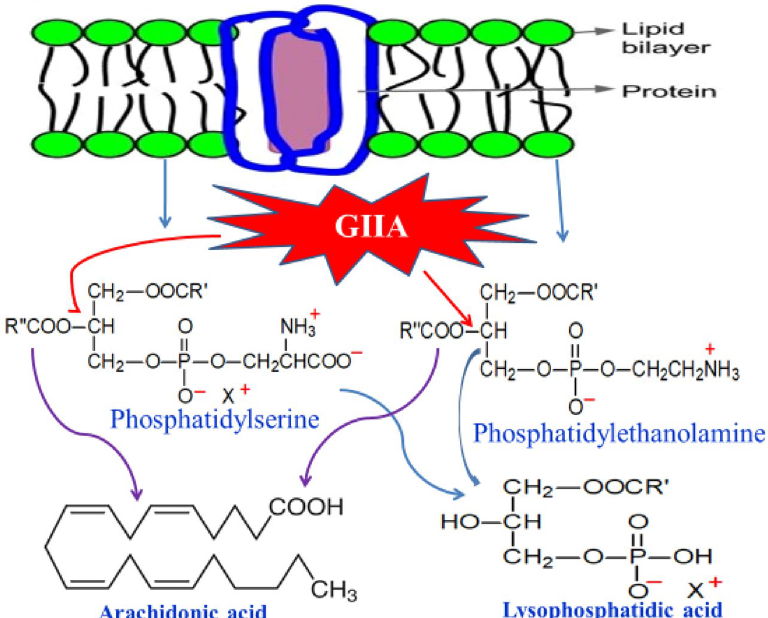
Figure 1. Schematic representation of GIIA catalytic hydrolysis of membrane phospholipids into arachidonic acid and lysophosphatidic acid.